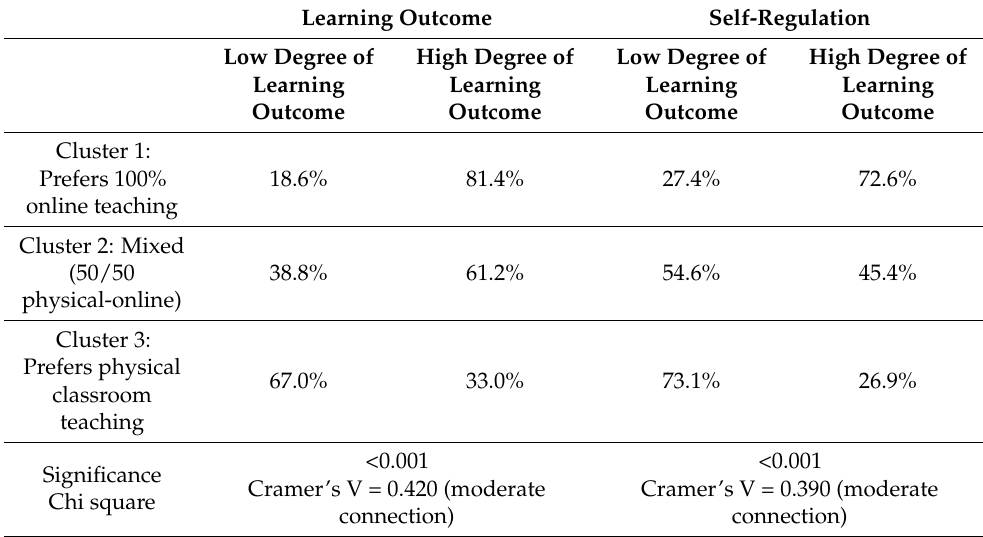
Table 1. Learning gradient and self-regulation